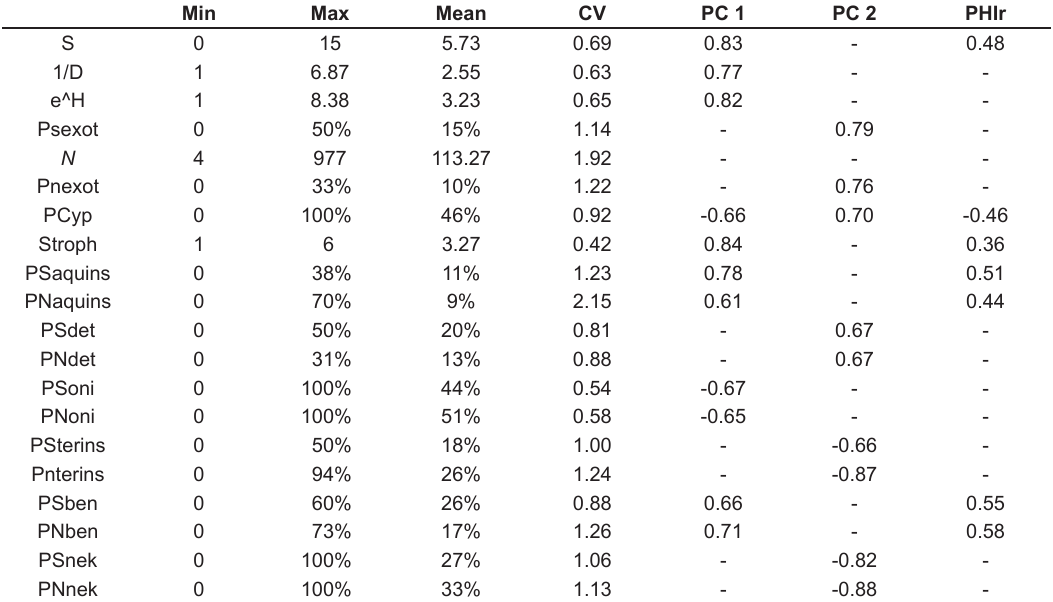
Table 6. Minimum (Min), maximum (Max), mean and coefficient of variation (CV) of the candidate metrics (see Table 3) for the multimetric fish index (MFI). Range and responsiveness significance: PCA metric loadings (PC1 and PC2) and Pearson correlation coefficient with PHI (PHIr).